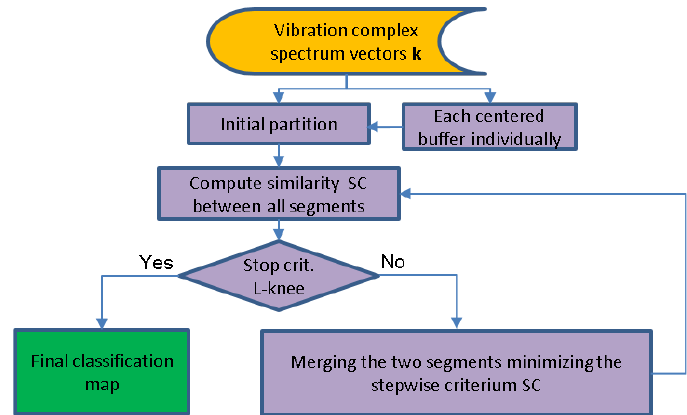
Figure 6. Flowchart of the proposed hierarchical segmentation